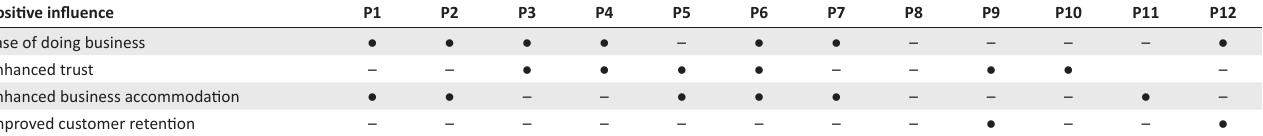
TABLE 3: Positive influences of interpersonal relationships on inter-organisational relationships. Positive influence P1 P2 P3 P4